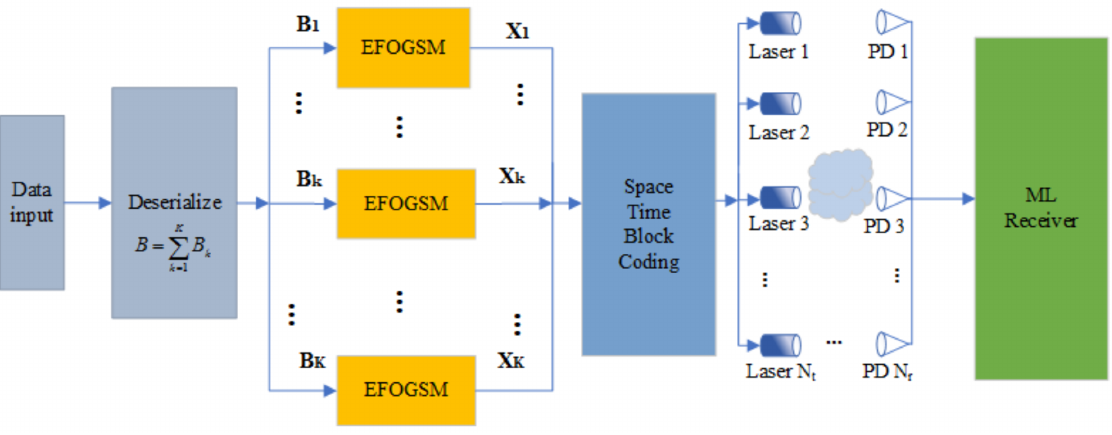
Figure 2. System models of the